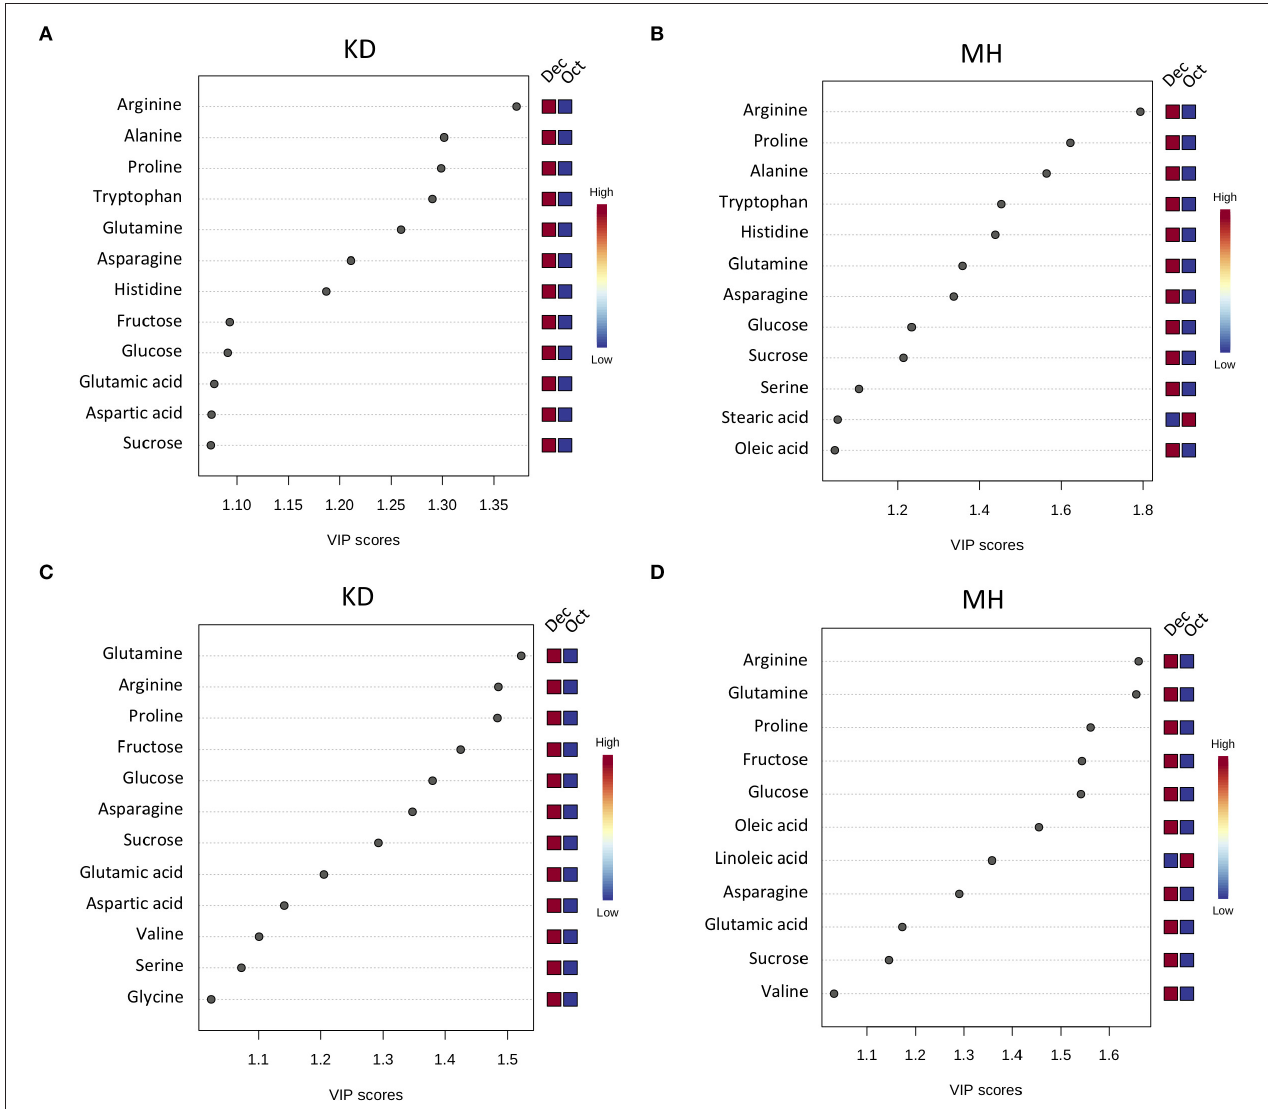
FIGURE 4 | Variable importance in projection (VIP) plots with the important metabolites in response to frost stress identified by PLS-DA analyses in descending order of importance in the stem (A,B) and the bud (C,D) of KD and MH. The colored boxes on the right indicate the relative concentrations given on a scale of high (red) to low (blue) for the corresponding metabolite in each